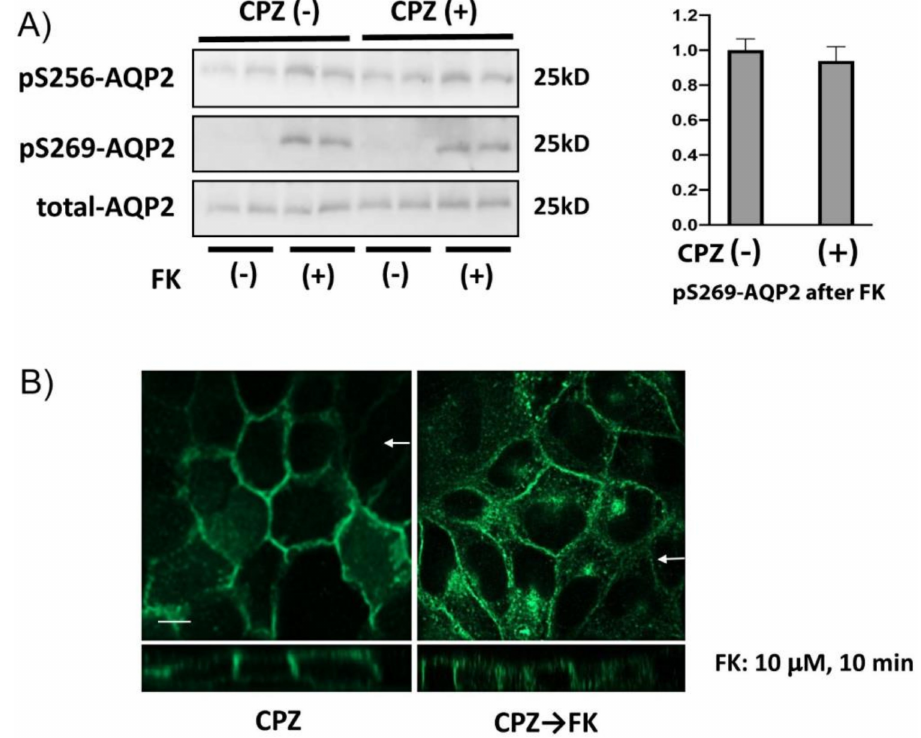
Figure 8. The e ff ect of CPZ on FK-mediated AQP2 phosphorylation and translocation. ( A ) AQP2-MDCK cells were pretreated with or without chlorpromazine (CPZ, 100 µ M for 15 min), stimulated with forskolin (FK, 10 µ M for 10 min), and then were subjected to Western blotting. The FK-induced